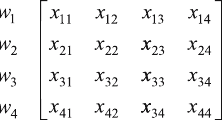
Figure 3: Text vectors arranged as a two - dimensional matrix.